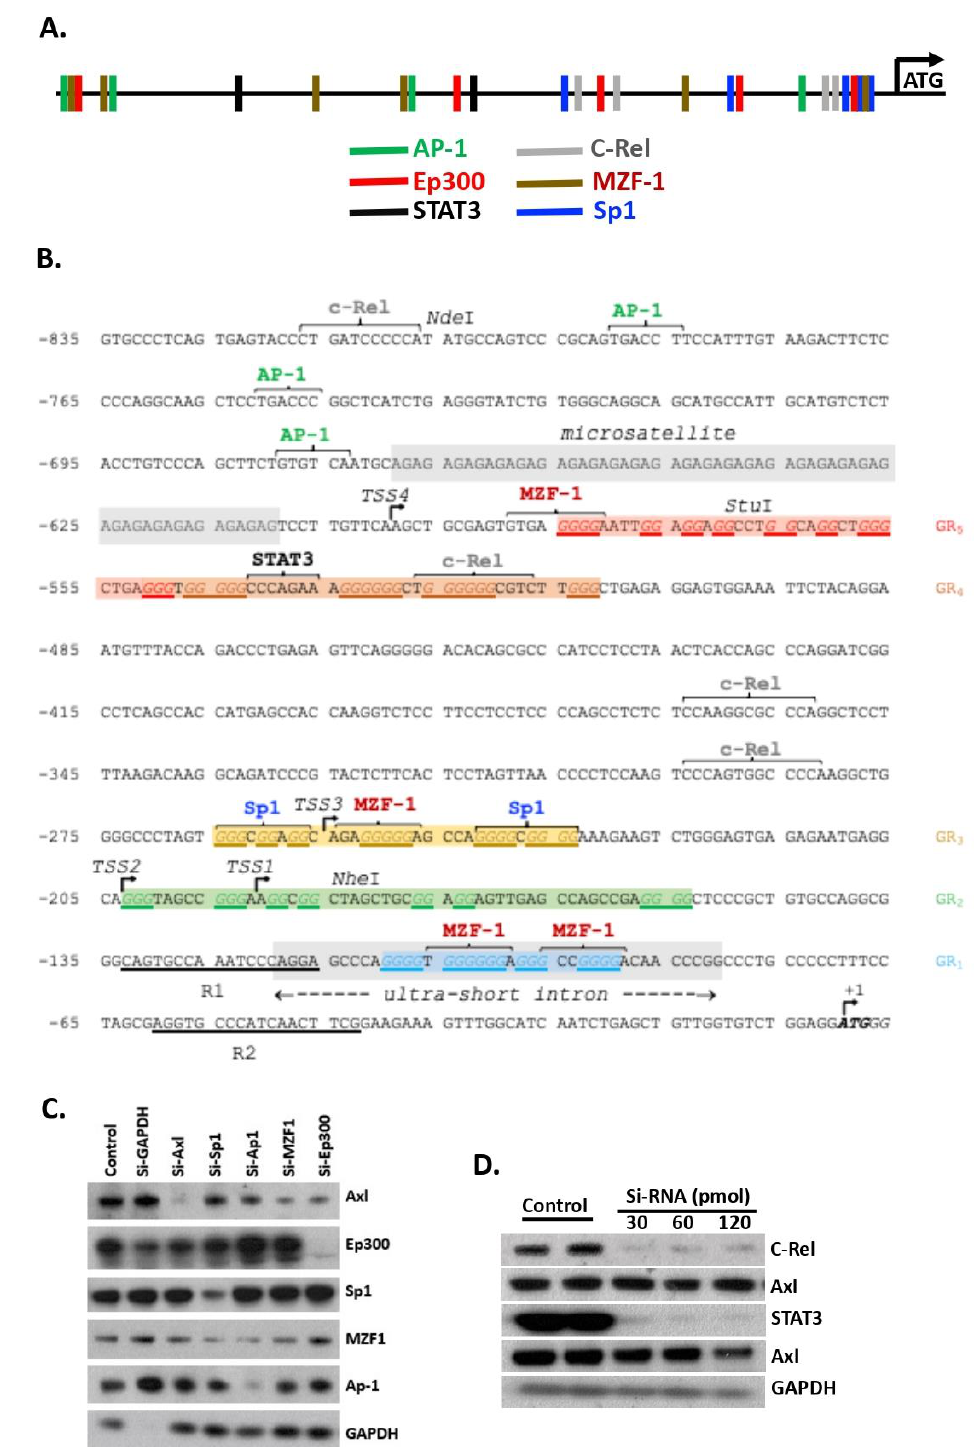
Figure 1. Axl expression is regulated by multiple transcription factors in renal mesangial cells . ( A ) characterized potential TF binding sites; ( B ) s chematic representation of the 5′ flanking region of Axl proximal promoter with putative TF binding sites. Secondary structures are highlighted. TSS, transcription start site. GR, potential G-rich quadruplex regions; ( C , D ) SV40-mesangial cells were treated with siRNAs (Sp1, Ap-1, MZF1, and Ep300 in ( C ); C-Rel and STAT3 in ( D )). Expression levels of Axl, and transcription factors were analyzed by Western blot. GAPDH was used as a loading control and internal siRNA control. Data shown were representative of three